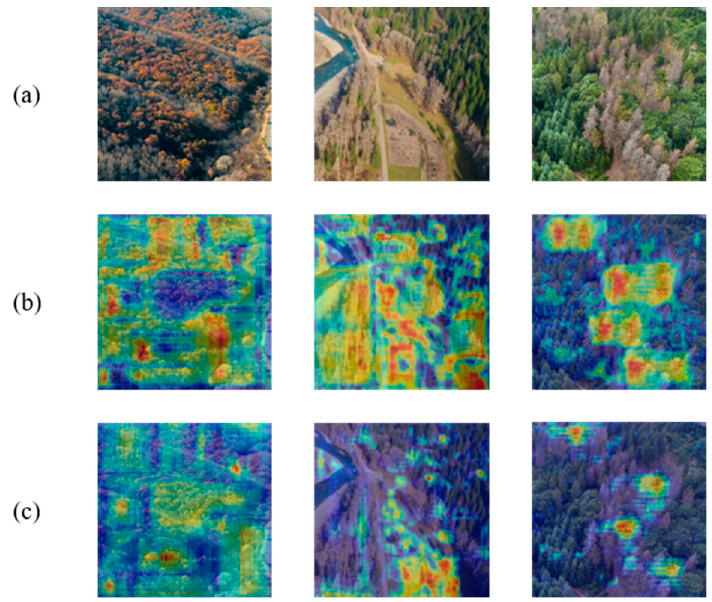
Figure 8. Class activation maps(CAM): ( a ) Original picture ( b ) LLAM-MDCNet ( c ) DenseNet.